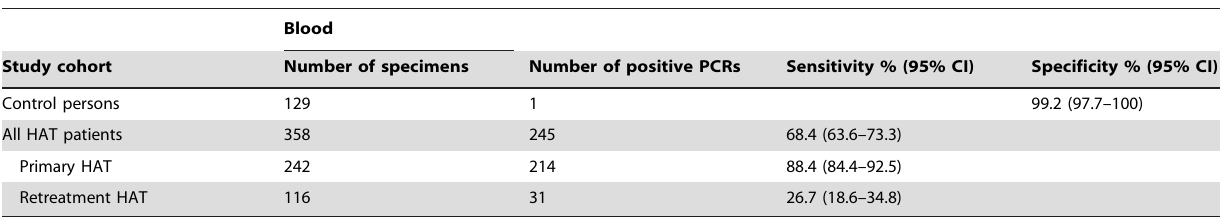
Table 1. Sensitivity and specificity of PCR on blood for diagnosis of HAT.